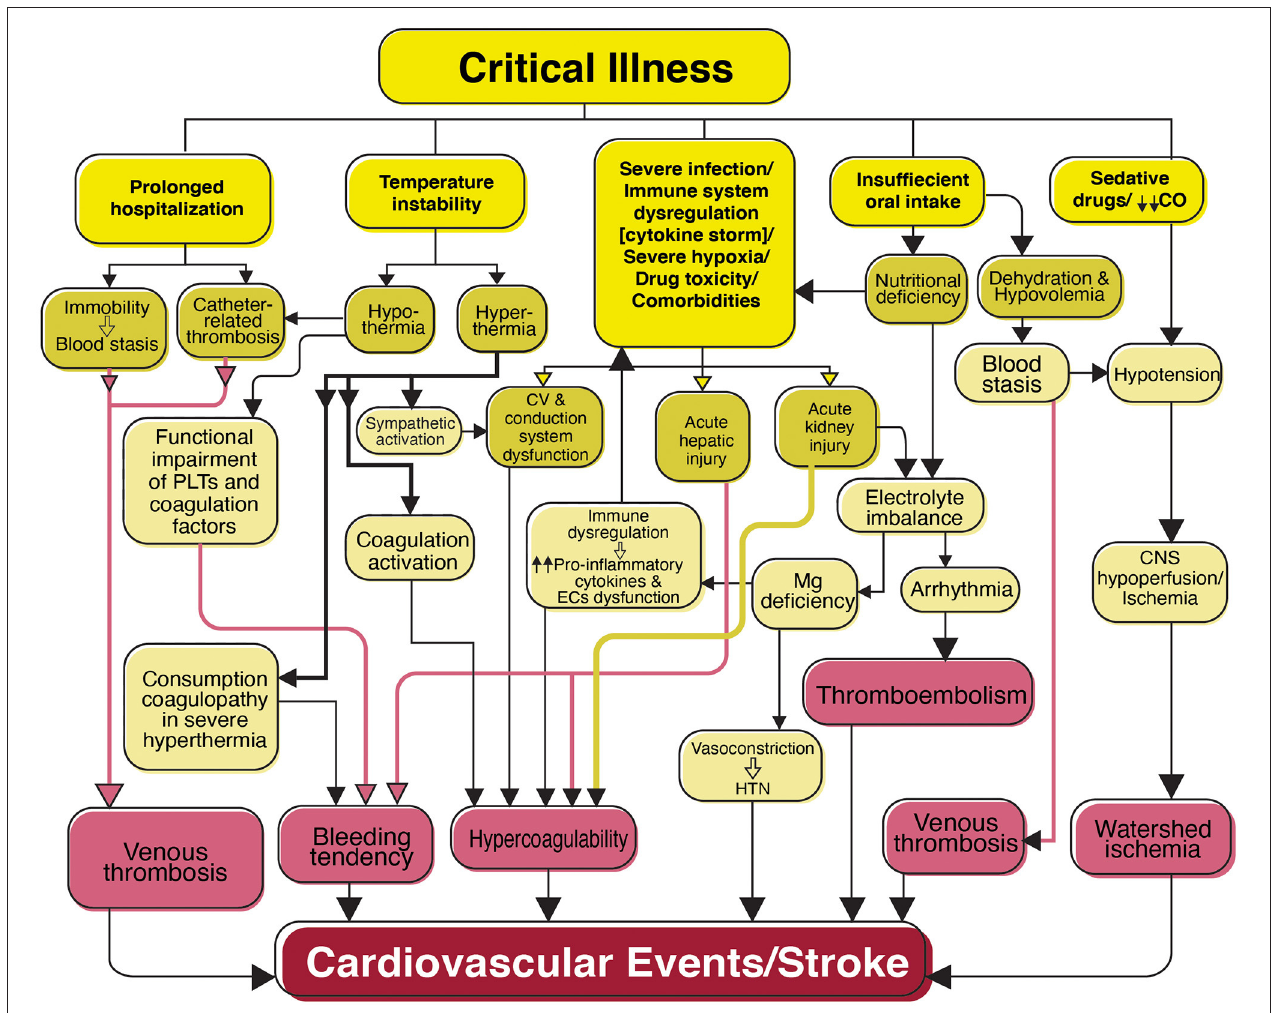
FIGURE 4 | Flowchart diagram shows features of critical illness predisposing the patients with SARS-CoV-2 infection to cardiovascular events and stroke. Patients with a critical illness are mostly admitted to the intensive care unit (ICU) for prolonged periods. Clinical complications associated with critical illness including prolonged hospitalization, temperature instability, severe infection, and immune dysregulation, severe hypoxia, drug toxicity, comorbidities (e.g., diabetes mellitus, cardiovascular disease, and hypertension), insufficient oral intake, and sedative drugs are shown in association with their consequences that may result in cardiovascular events and stroke. PLTs, Platelets; CV, Cardiovascular; EC, Endothelial cells; Mg, Magnesium; HTN, Hypertension; CO, Cardiac output; CNS, Central nervous